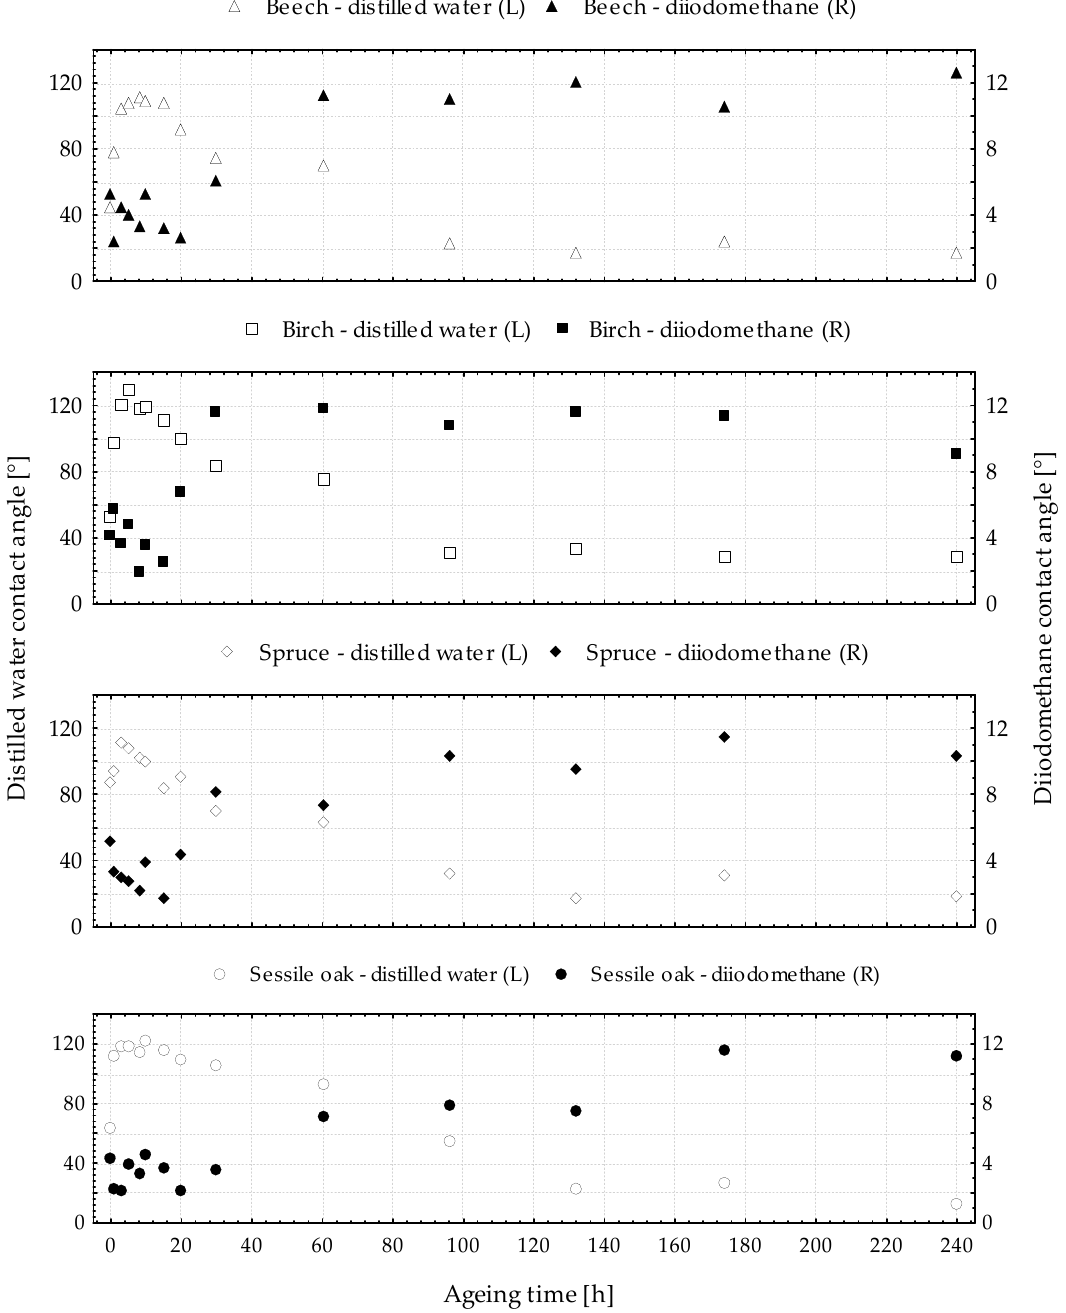
Figure 2 . Contact angle values of distilled water and diiodomethane during artificial ageing, L—left y-axis, R—right y-axis.